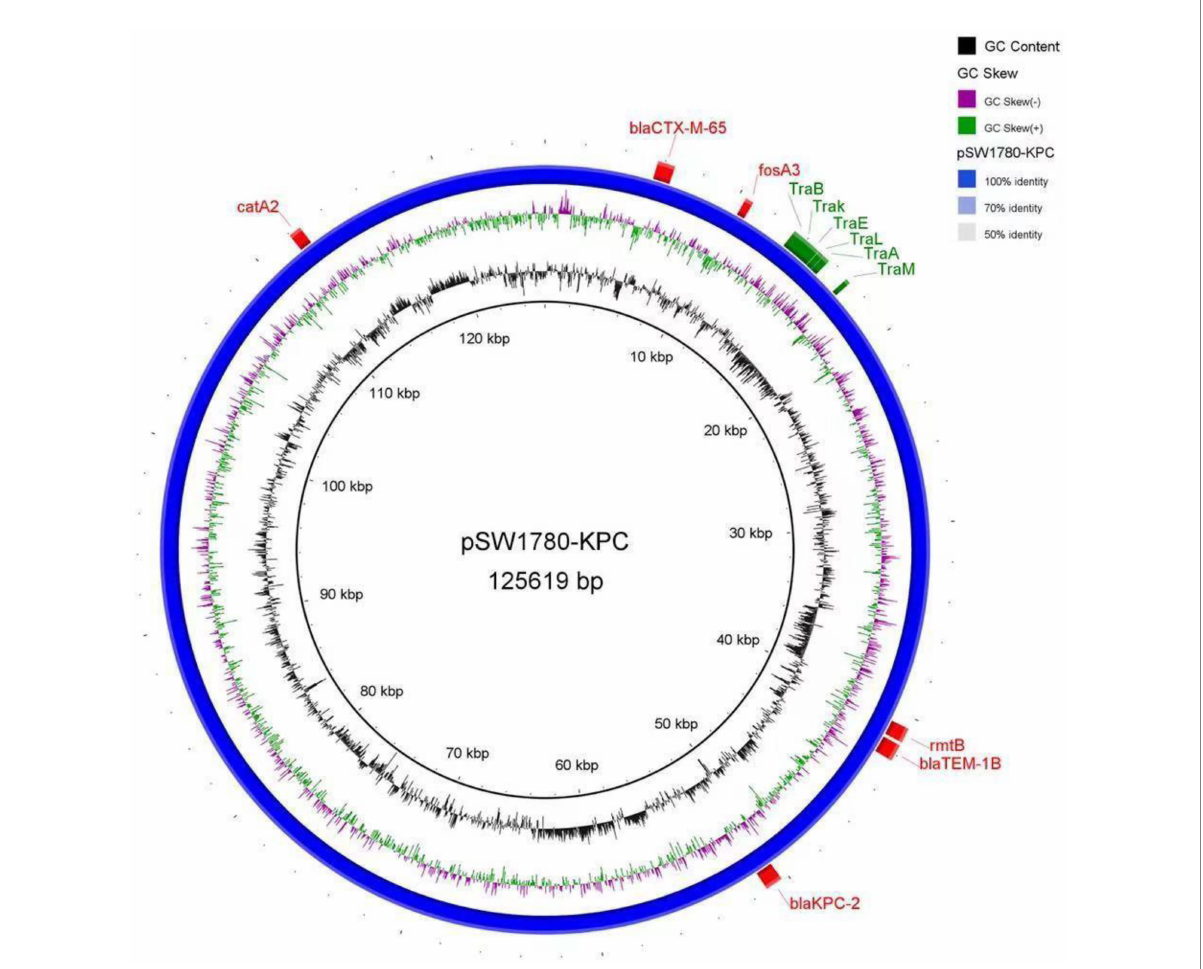
FIGURE 1 DNA sequence diagram of plasmid pSW1780-KPC. The first circle represents GC content. The second circle indicates the GC skew. The blue circle represents the whole sequence of the plasmid. Externally to the blue circle, red boxes represent antibiotic resistance genes, and green boxes represent conjugation-related genes.